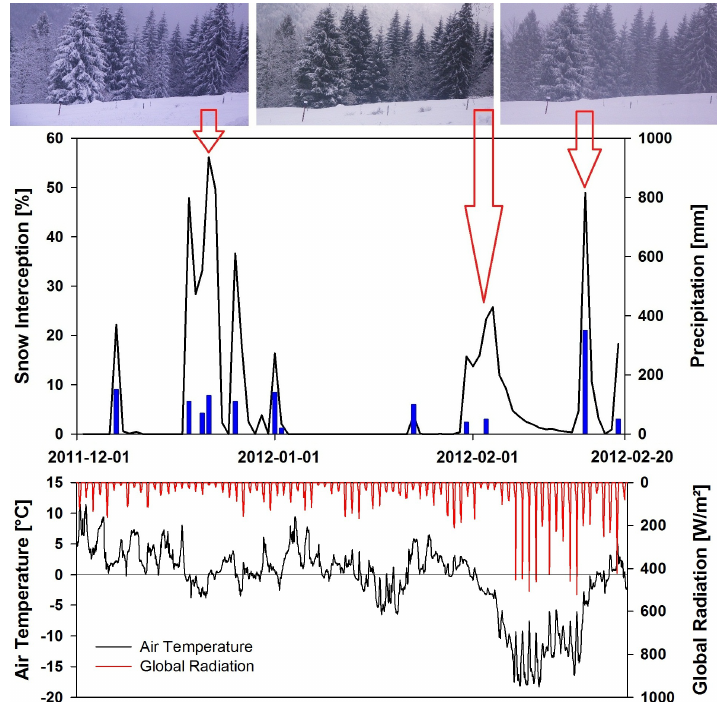
Fig. 9. Interception of snow as percentage of white pixels in the ROI in a conifer forest canopy observed during different snowfall events in winter 2011/2012 with measured air temperature and incoming solar